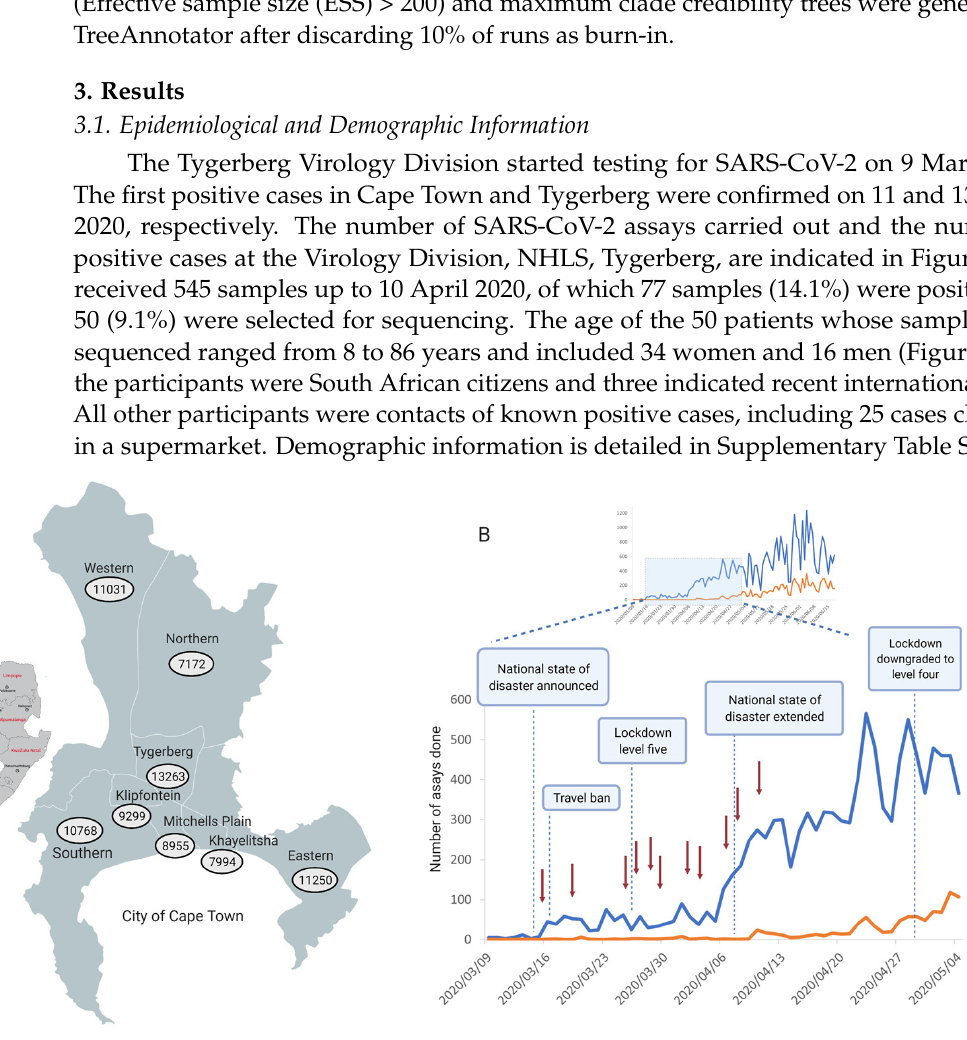
Figure 1. Epidemiology of SARS-CoV-2 in the Western Cape and the City of Cape Town. ( A ) Map of South Africa indicating the different provinces with a map of cases in the Cape Town Metropole on 31 July 2020 in the eight different health subdistricts. Data were obtained from the Western Cape Provincial Government, https://coronavirus.westerncape.gov.za, last accessed 21 March 2021. ( B ) Graphical presentation of the number of SARS-CoV-2 assays carried out and the number of positive cases at the Virology Division, NHLS, Tygerberg. The detailed view from 9 March 2020 indicates the timeline of the government response to the epidemic, with red arrows indicating early sample collection for sequencing at Tygerberg Hospital. Figure created using BioRender (https://biorender.com, last accessed 21 March